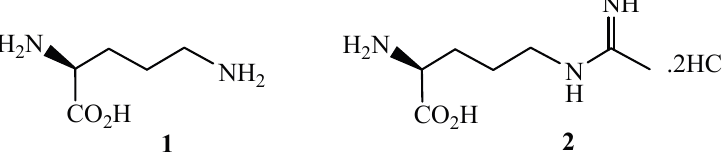
Figure 1. Structures of L -ornithine ( 1 ) and L - N 5 -(1-iminoethyl)-ornithine dihydrochloride ( 2